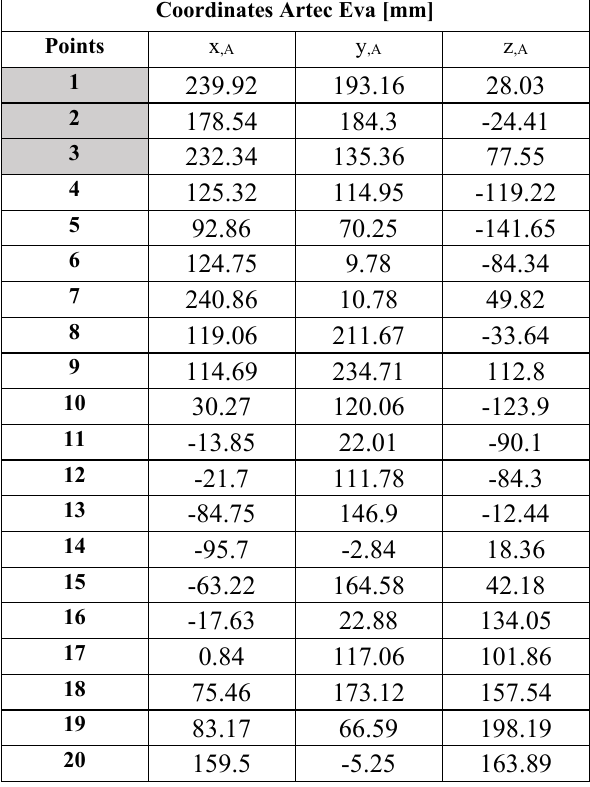
Table 10. Coordinates of the 20 points of Nikon D3200 model